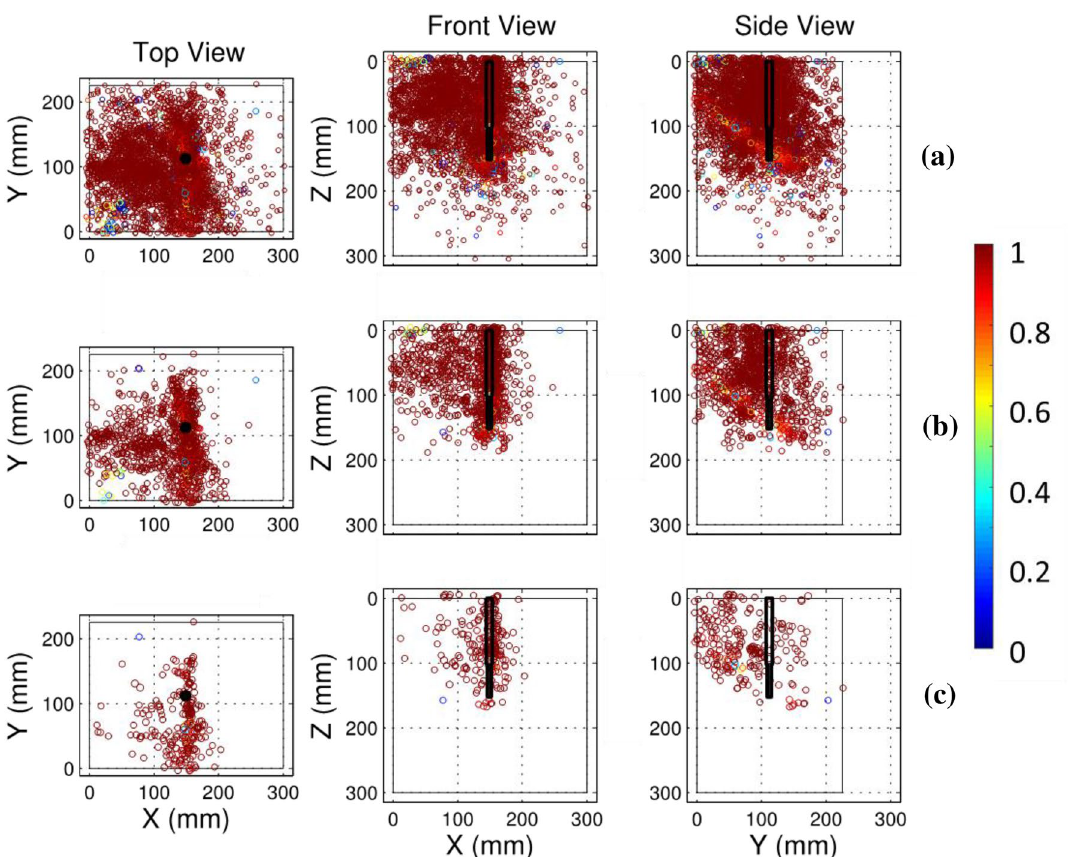
Fig. 5 AE event source locations showing very dense microcracking in the top half of the specimen. Correlation coefficient, or location accuracy is shown by color where 1/1 represents no location error and 0/1 represents very large location error. The colorbar on the right shows the distribution of color gradient. AE event amplitude is rep-